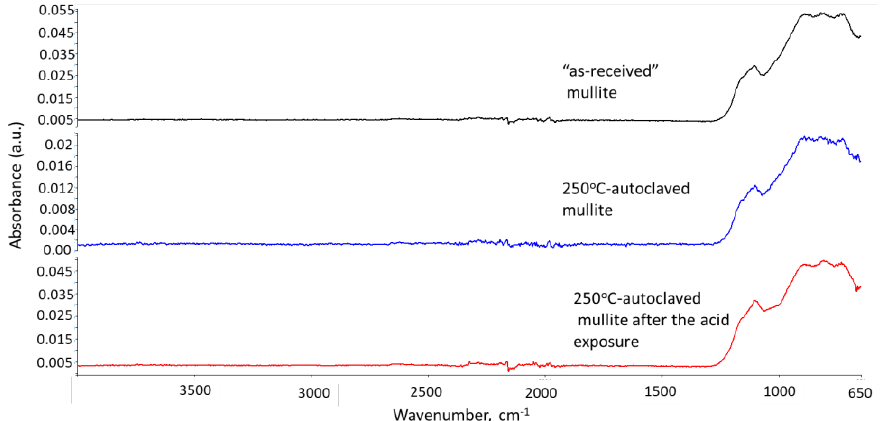
Figure 12. FTIR spectra of mullite samples from top to bottom: “as received” (before exposure) mullite, 250 °C-autoclaved mullite and mullite exposed to the strong acid.